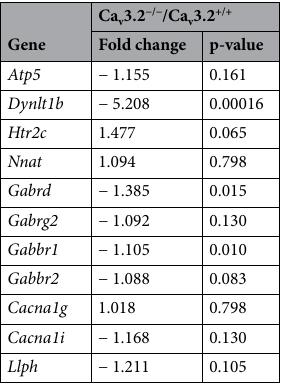
Table 2. Fold changes of selected microarray gene candidates from Cav3.2 +/+ and Cav3.2 −/− hippocampi. CNRQ values are normalized to a calibrator (see “Materials and methods” section) and statistically evaluated using the Mann–Whitney test in qBase plus